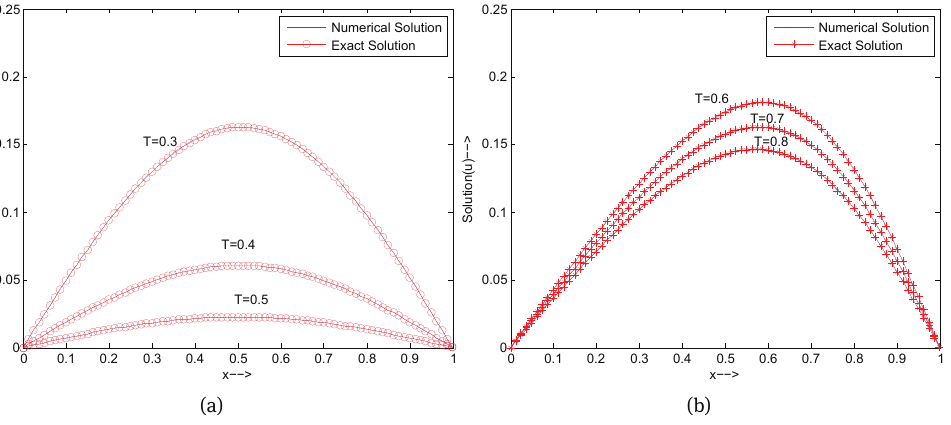
Fig. 9: Numerical solutions of Example 3 at different times for Δx = 0.0125 and different values of ν and Δt , (a) ν = 1 , Δt = 0.0001 (b) ν = 0.1 , Δt = 0.001